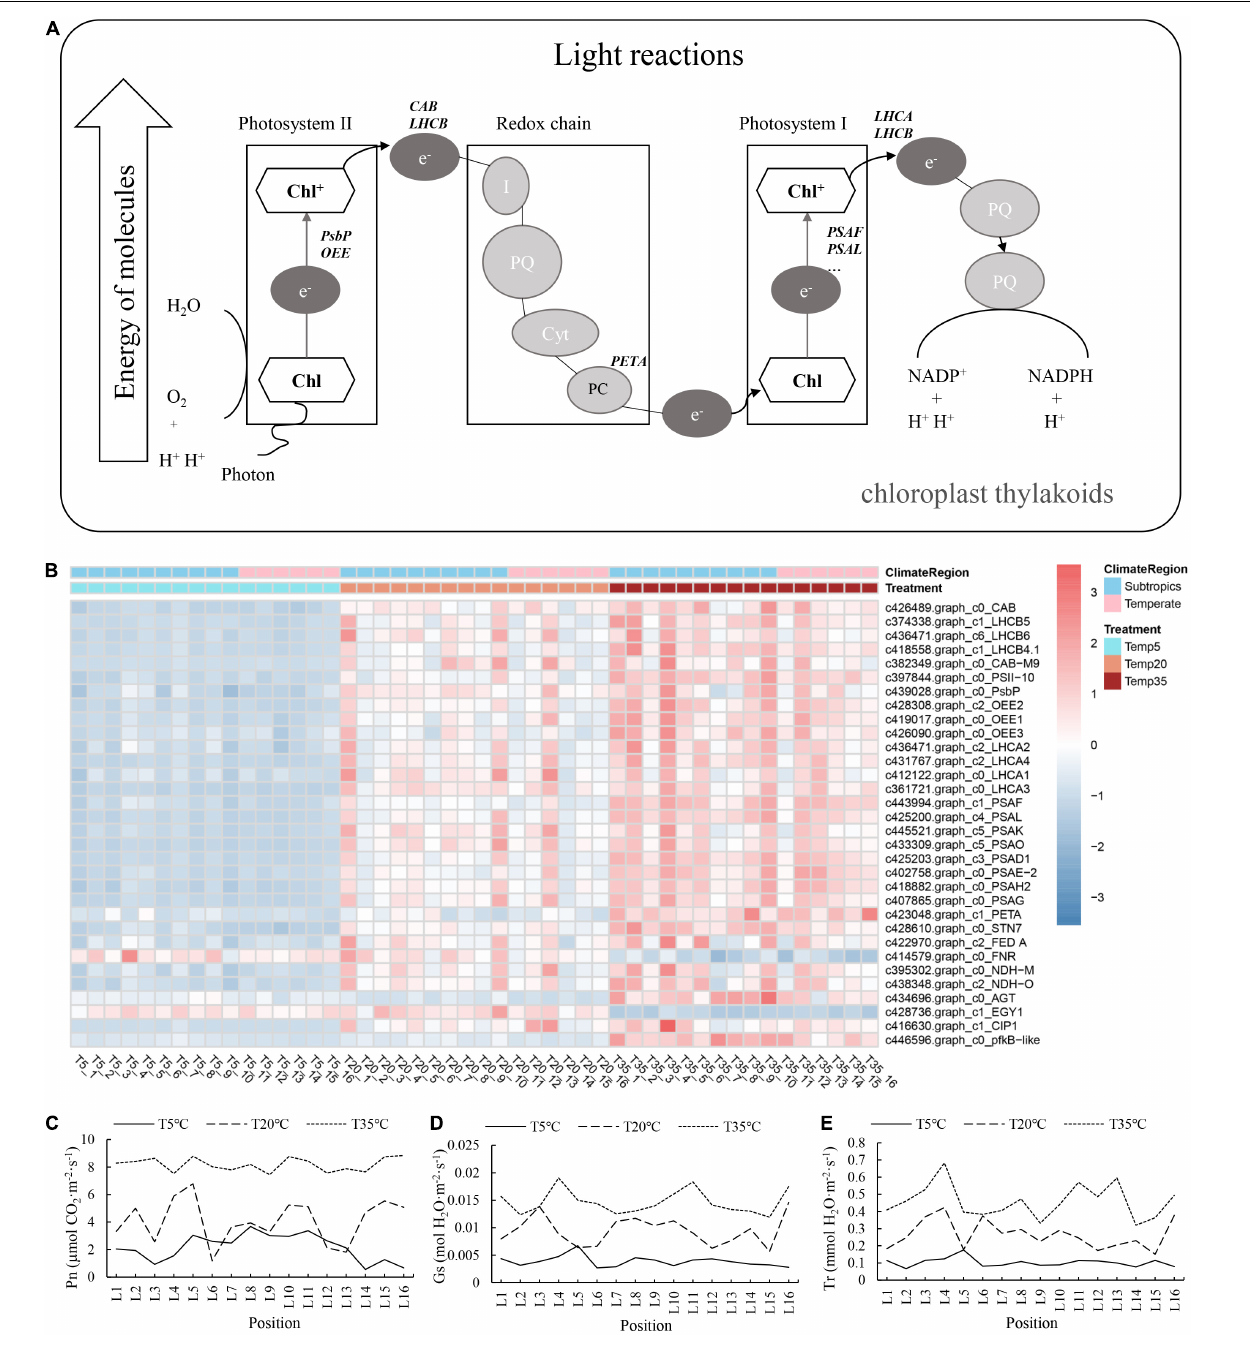
FIGURE 5 | (A) Photosynthesis pathways in association with differential expression in bermudagrass. (B) Heatmap showing the expression profile of DEGs involved in photosynthesis pathways. (C–E) Histogram showing variation in photosynthesis indexes at different temperature, followed by the net photosynthetic rate (Pn), stomatal conductance (Gs), and transpiration rate